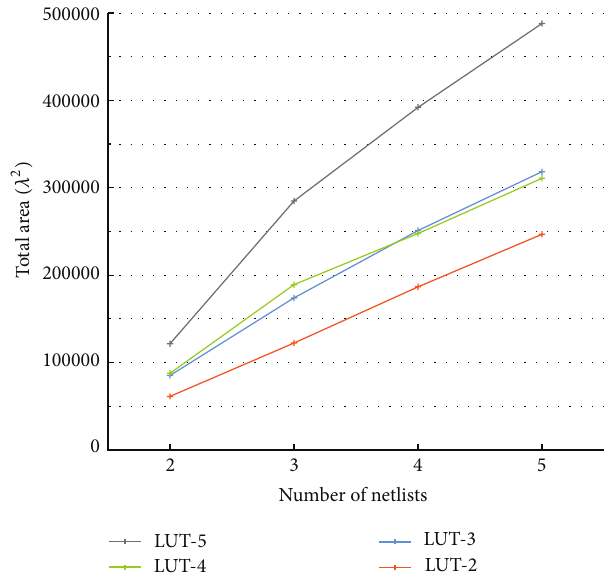
Figure 18: Total mASIC area comparison for different LUT size.